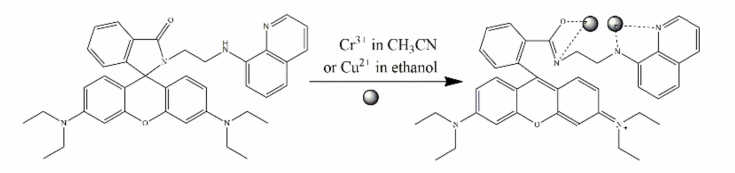
Figure 57. The sensing mechanism of this prepared sensor (Table 4, No. 8) for Cr 3+ and Cu 2+ [113]. A sensor, with a dual function of distinguishing Al 3+ and CN − , named sensor No.9 in Table 4 [114], showed strong fluorescence and pink color for Al 3+ , specifically recognizing CN − with a detection limit of 0.815 × 10 − 8 M accompanied by reduced fluorescence intensity. The possible binding mechanism of the prepared sensor with Al 3+ and CN − is shown in Figure 58. A rhodamine-based sensor, MF-N 3 (Table 4, No. 10), was reported by Zhu L., et al. to selectively accumulate in lysosomes and show turn-on fluorescence for both H 2 S and H + [115]. Owing to ingenious molecular design, MF-N 3 exhibited strong fluorescence with H 2 S only in acid conditions, since endogenous H 2 S is mainly produced in cells with pH in the acidic range. This sensor containing the spirolactam group was modified with 4-azidobenzyl carbamate that reacted with H 2 S and then transformed to amine, enabling strong fluorescence (Figure